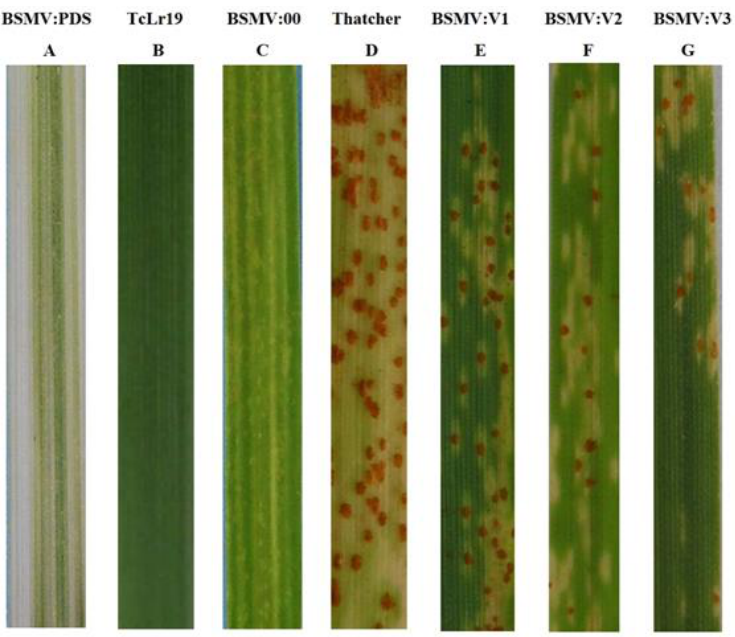
Figure 4. Phenotypic characterization of wheat leaves after virus-induced TaABCG36 -gene silencing. ( A ) (BSMV:PDS): TcLr19 infiltrated by BSMV:PDS; ( B ) (TcLr19): wild type of TcLr19; ( C ) (BSMV:00): TcLr19 infiltrated by BSMV:00; ( D ) (Thatcher): the susceptibility line. ( E – G ) (BSMV:V1-V3): TcLr19 infiltrated by BSMV:V1, BSMV:V2, and BSMV:V3, respectively. All these were inoculated with Pt pathotype THTS.